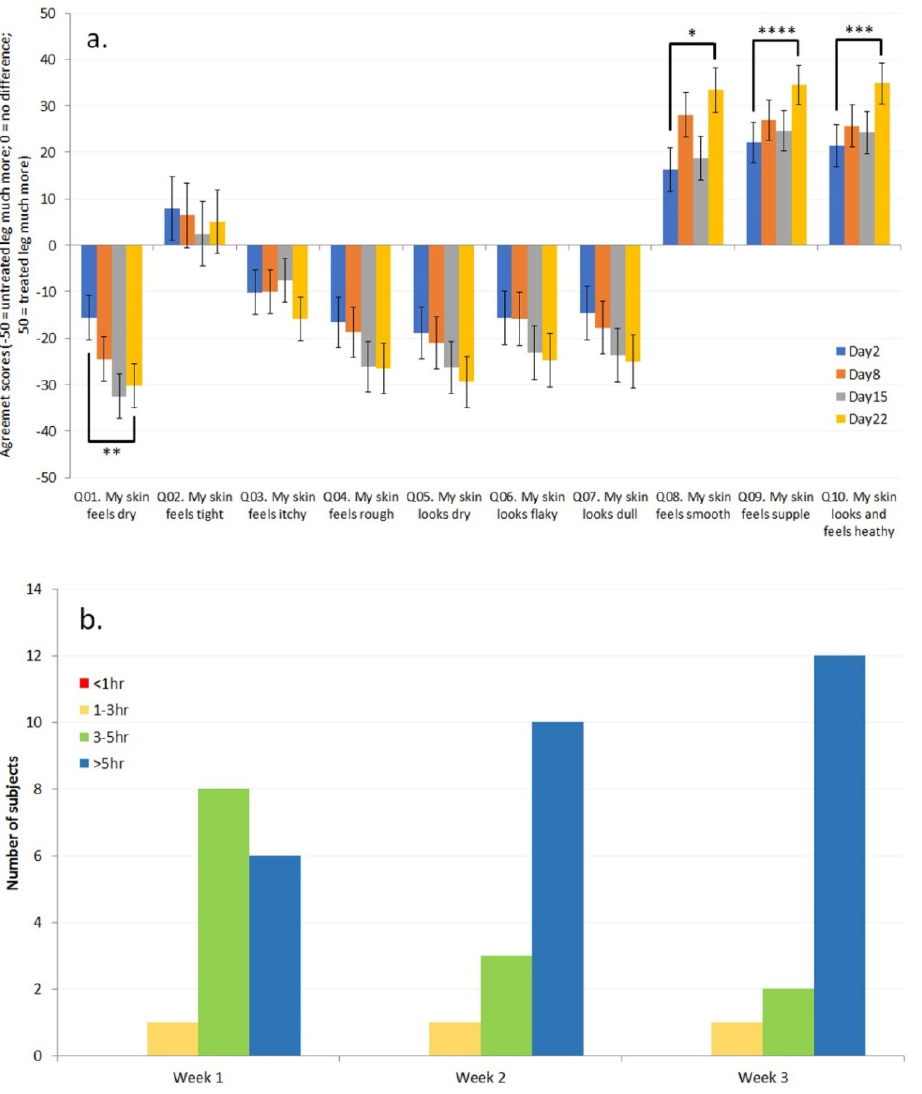
Figure 3. Subject feedback data during the study. ( a ) Comparison of the test (treated) and control (untreated) legs ( − 50 = untreated leg much more; 0 = no difference; 50 = treated leg much more) on day 2, 8, 15, and 22 (after 1 day and 1, 2 and 3 weeks of product usage). Statistical differences between the data for day 2 and day 22; * p < 0.05, ** p < 0.15, *** p < 0.20, **** p < 0.25. ( b ) Length of time before the subjects thought re-application of the product was required in week 1, 2, and 3.